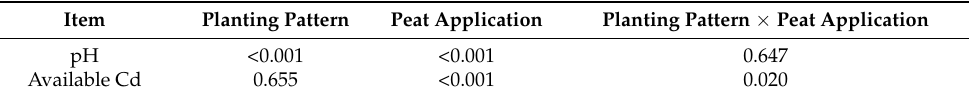
Table 3. ANOVA ( p values) of pH and available Cd (DTPA-extractable) in soil in different treatments.